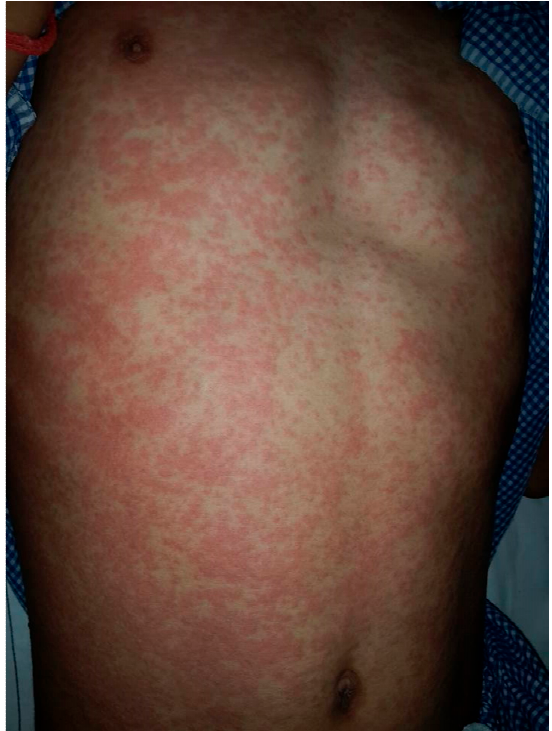
Figure 1. Maculopapular drug exanthem on abdomen.